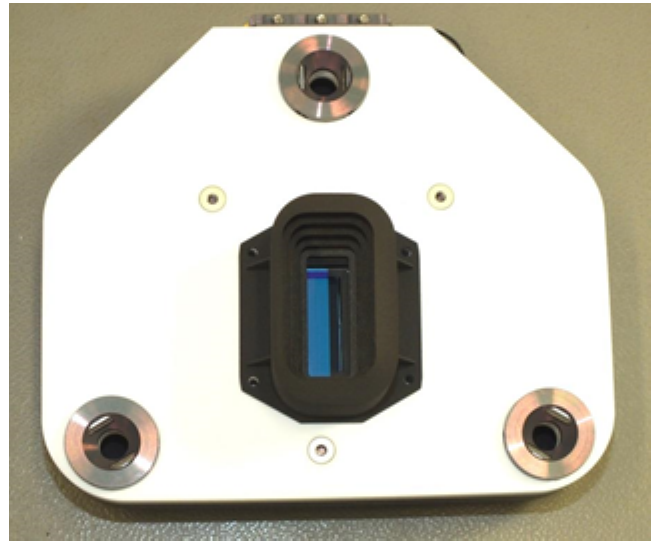
Figure 8. Focal plane assembly of